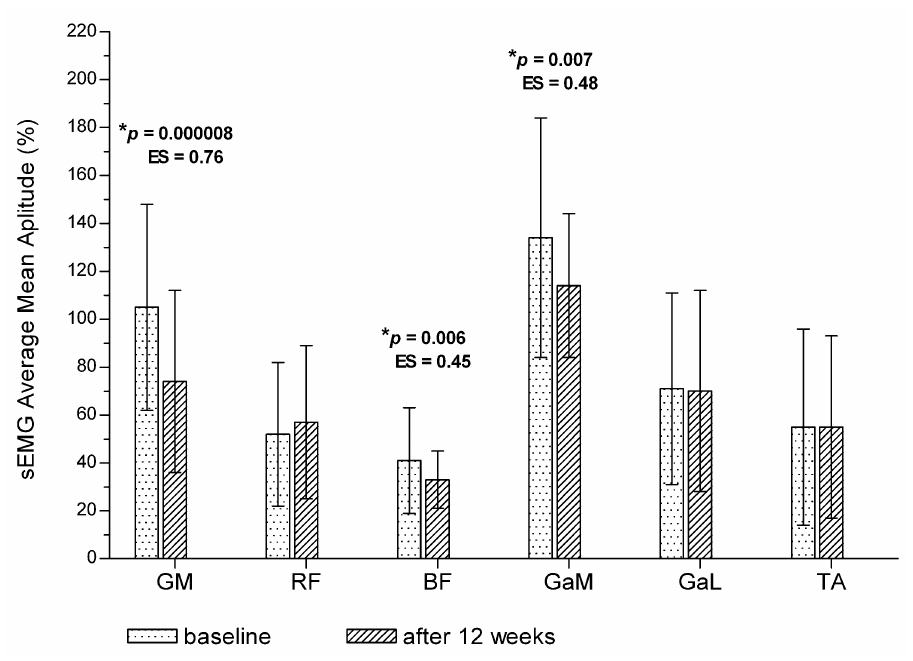
Figure 1. Post-training changes in average mean amplitude of sEMG for the entire treadmill test (total measurement). * p — p value between baseline and post-training value. ES — effect size (Cohen d). Values are expressed as mean ± SD.